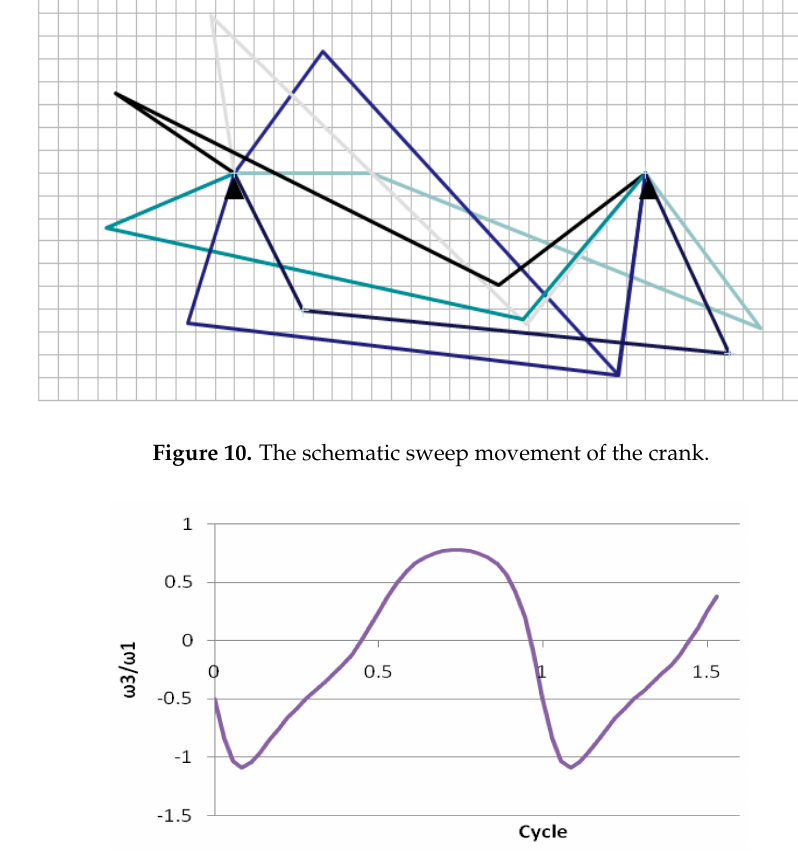
Figure 11. The non-dimensional angular velocity of the crank.